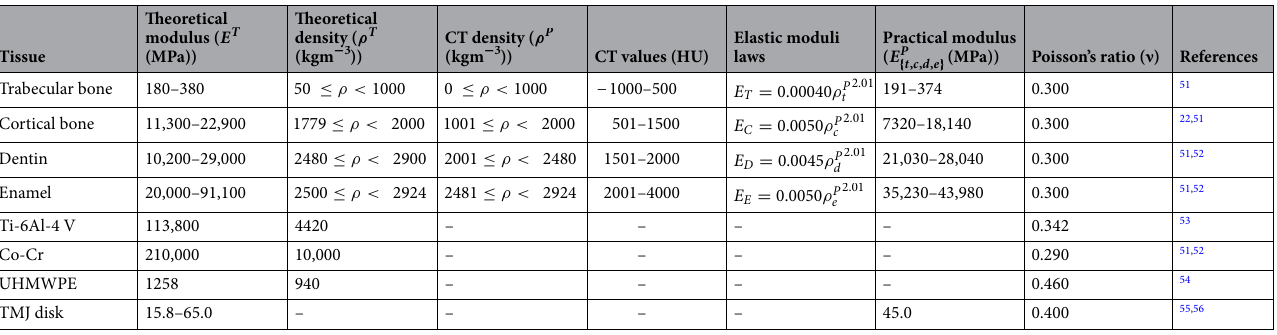
Table 2. Mechanical properties for the different tissue types considered in the finite element